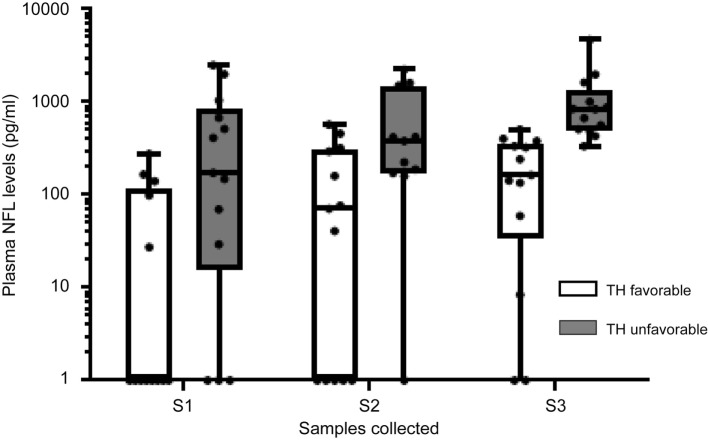
Temporal changes in plasma neurofilament light (NfL) levels in groups with different severity of brain injury. Data expressed as median with interquartile ranges and whiskers with minimum to maximum.